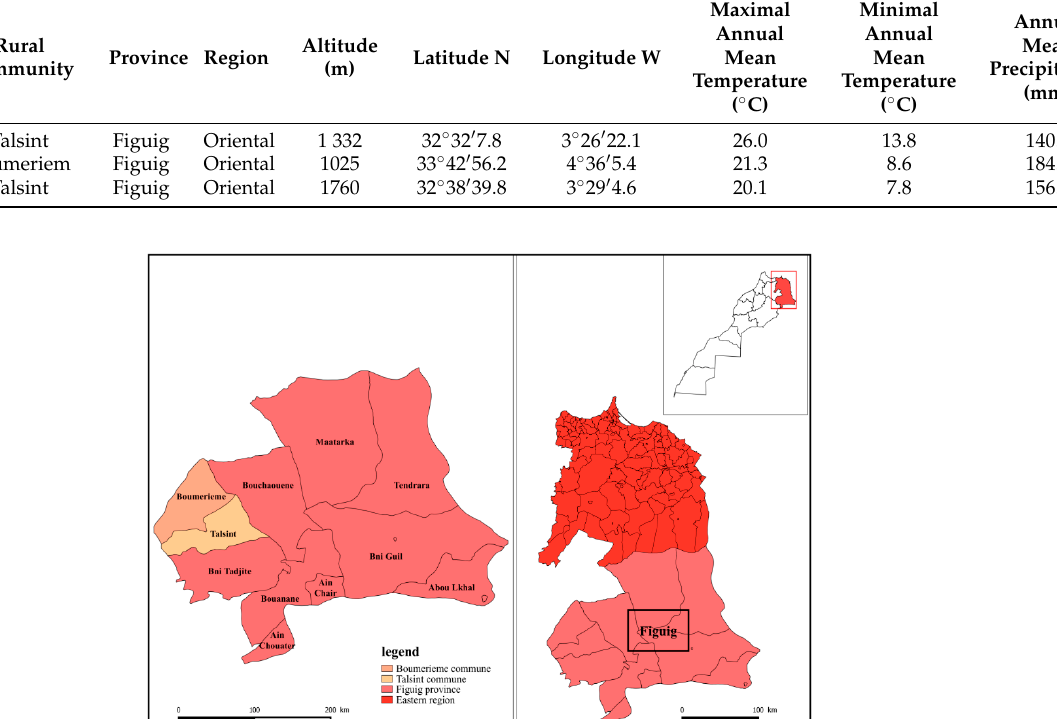
Table 4. Localization and the coordinates of the samples from the three cooperatives.